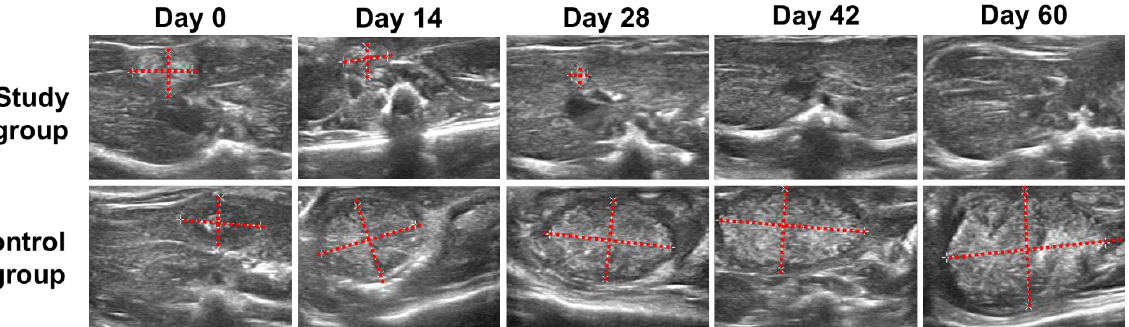
Figure 1. Ultrasound images of the rats in the study and control groups show tumour progression at Day 0, Day 14, Day 28, Day 42, and Day 60 post-injection of [ 153 Sm]Sm 2 O 3 -PS microspheres and saline solution. The red dotted lines show the horizontal and vertical diameters of the tumour.